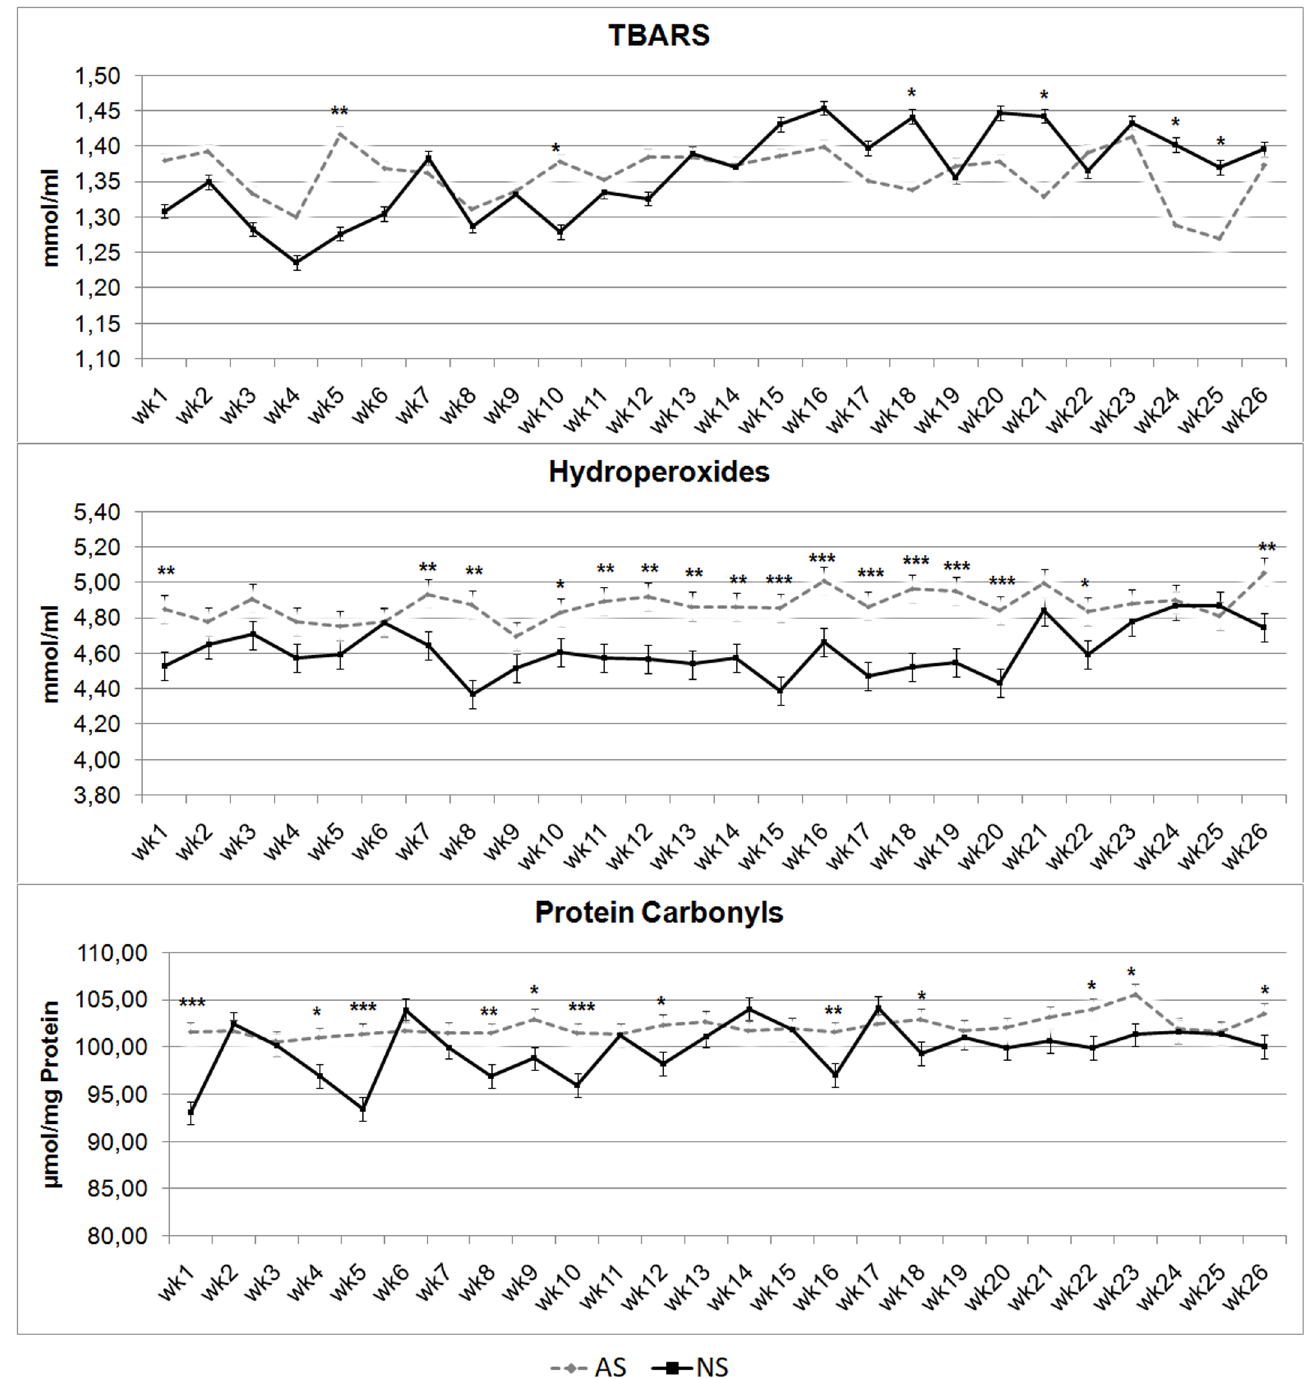
Fig 8. Thiobarbituric acid reactive substances (TBARS), hydroperoxides and protein carbonyls plasma concentrations in artificially-suckled (AS) and naturally-suckled (NS) donkey foalsduring the first 26 weeks of life (Values are Least Square Means; bars represents Standard Error of the Mean). Statistical differences between the two groups at the same week were expressed: (cid:3) = P < 0.05; (cid:3)(cid:3) = P < 0.01; (cid:3)(cid:3)(cid:3) = P < 0.001.